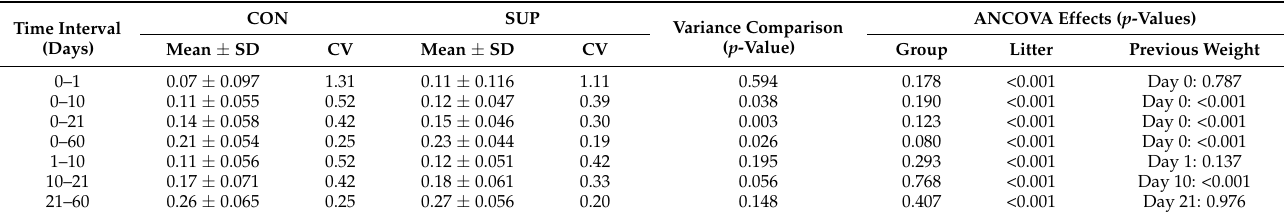
Table 3. Average daily gain (ADG: kgd − 1 ) for survivor piglets for several time intervals from the CON ( n = 166) and SUP ( n = 159) groups. SD: Standard deviation. CV: Coefficient of variation. CON: control group; SUP: colostrum supplemented